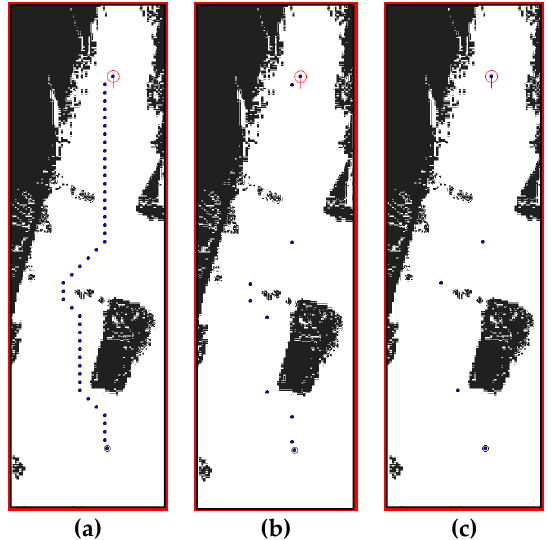
Figure 5. ( a ) Path point set is produced by A-Heuristic algorithm; ( b ) significant point set; ( c ) reduced significant point set by using regression search method.